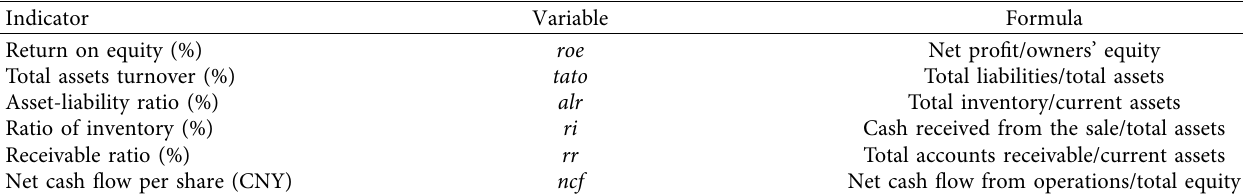
Table 2: Selection of indicators.